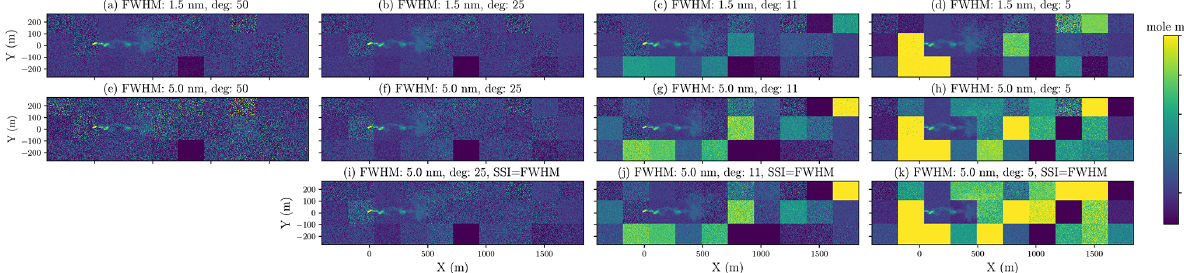
Figure 12. Retrieved CH 4 column over 30 different surfaces with varying instrument scenarios. The top row shows the results for an instrument with a FWHM of 1.5nm, while the second row shows the results for an instrument with a FWHM of 5.0nm. Both the top and middle rows have SSI = FWHM / 2.5. The bottom row shows the results for an instrument with FWHM of 5.0nm and SSI = FWHM. The biases drop significantly as the polynomial degrees